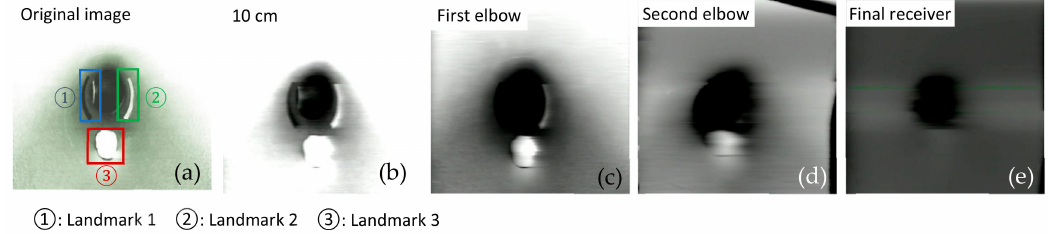
Figure 7. Analog image transmission with visible light in the water